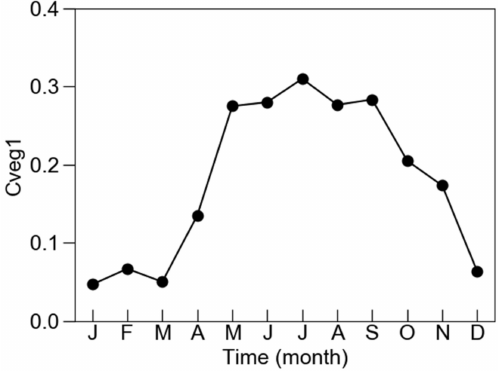
Figure 11. Monthly averaged C veg1